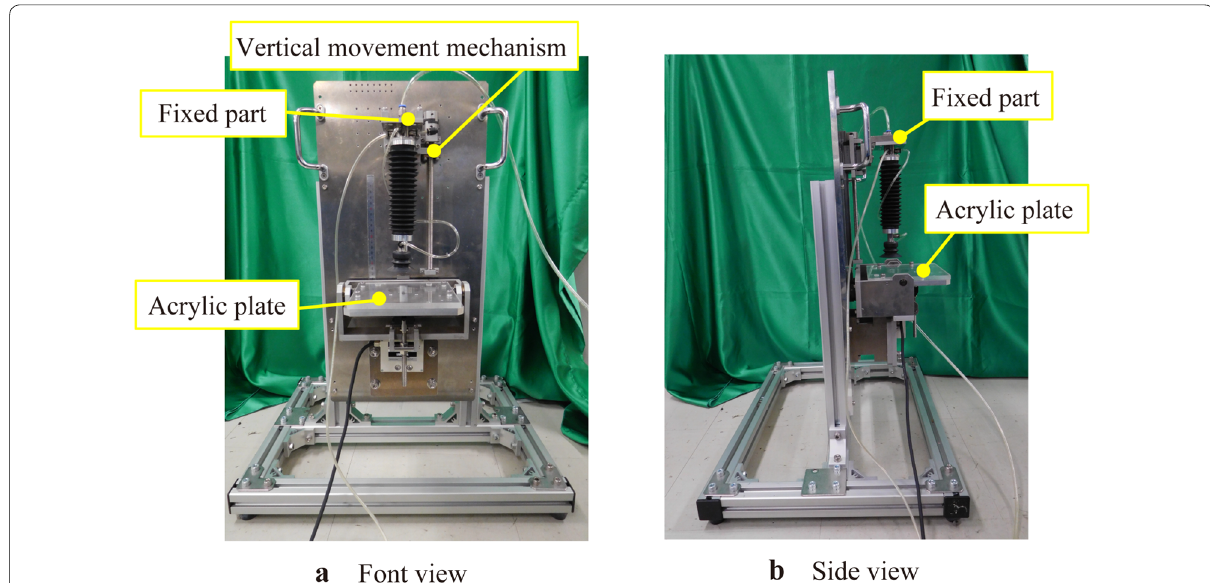
Fig. 13 Characteristic evaluation device for the suction pad unit. a Front view, b side view. The developed suction pad unit was attached to the evaluation